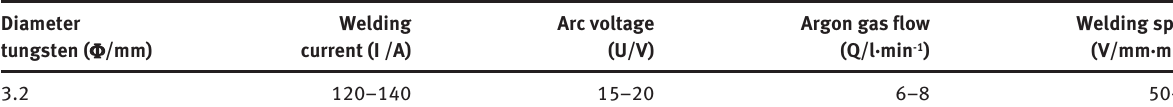
Table 3 The TIG welding parameters used in iron-based alloy cladding.